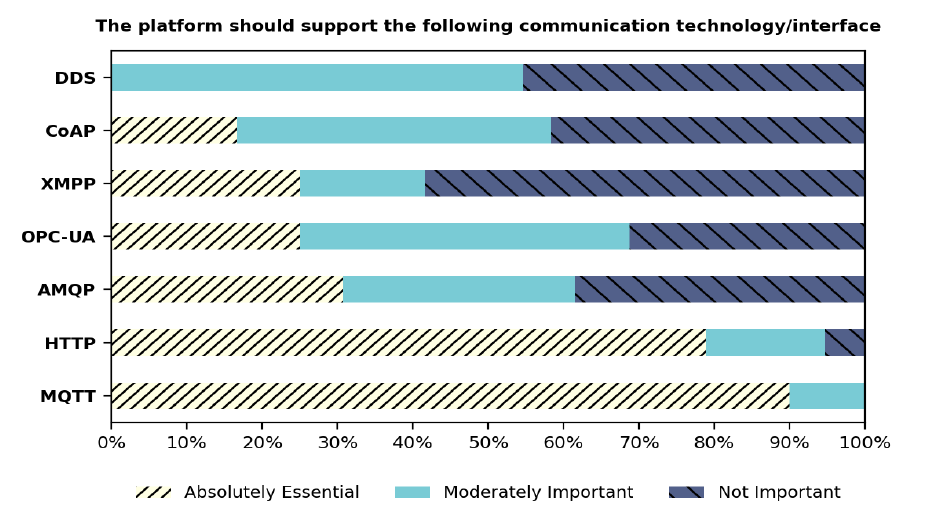
Figure 8. Responses to a survey question about the communication protocols that need to be supported by the IoT middleware